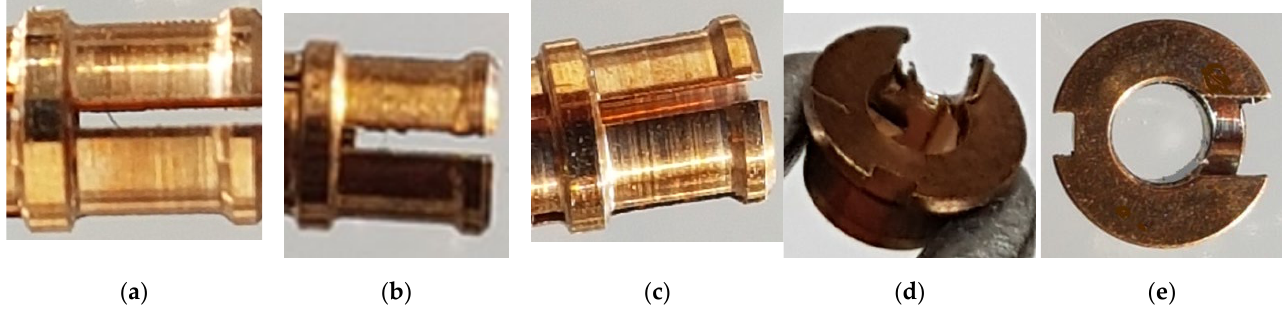
Figure 3. Removal of burrs from the parts made of BrB2 in the Pulsar VKF 3.250 thermal pulse installation: ( a ) the part before processing with burr in the slot of the lamella (the dimensions are D = 3.1 mm, L = 6.5 mm); ( b ) the part after processing, the roots of burrs remained in the slot of the lamella; ( c ) the part after processing in a rational mode, burrs with a root thickness of less than 0.07 mm are removed, and the surface quality and dimensions are preserved; ( d ) the part with burrs with the root thickness less than 0.1 mm (the dimensions are D = 4 mm, L = 2 mm) before processing; ( e ) the part after double processing in a rational mode with burrs removed and matte surface and dimensions